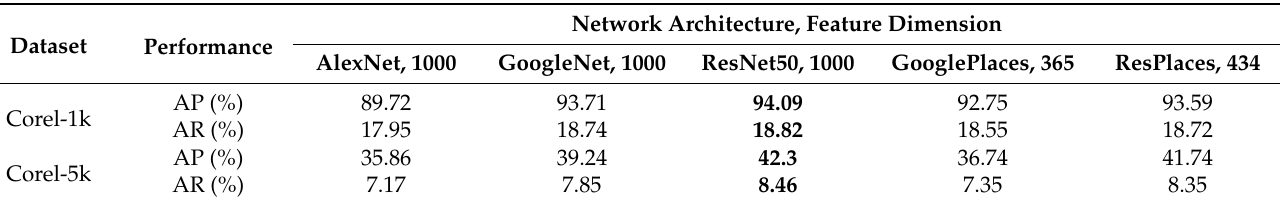
Table 4. APs and ARs results using deep features extracted from different networks, Top NR = 20. Dataset